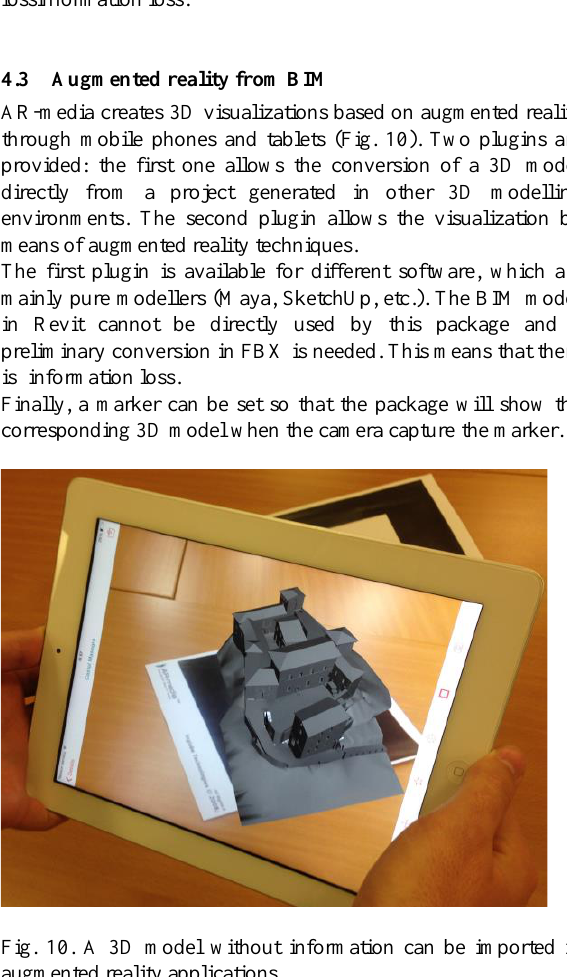
Fig. 9. The virtual tour generated in iVisit3D required the preliminary conversion of the BIM with a complete information lossinformation loss.